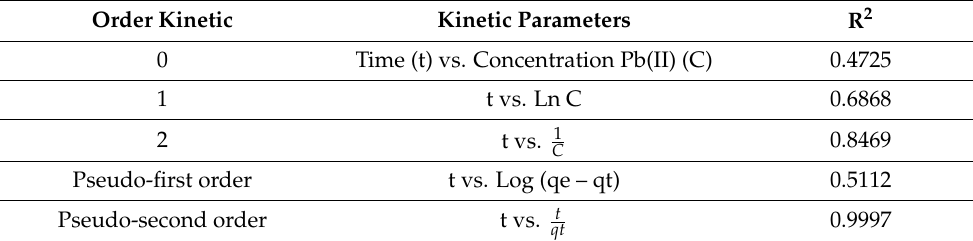
Table 2. Kinetic models applied to the biosorption process, parameters and R 2